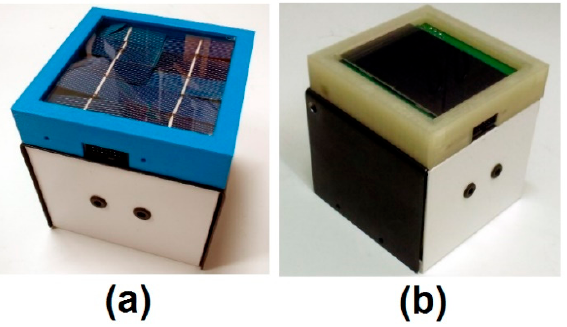
Figure 4. Photographs of constructed devices based on silicon solar cells and supercapacitors: ( a ) ten silicon photovoltaic cells with size 50 mm × 20 mm connected in series and ( b ) two silicon photovoltaic cells with size 70 mm × 50 mm connected in parallel.